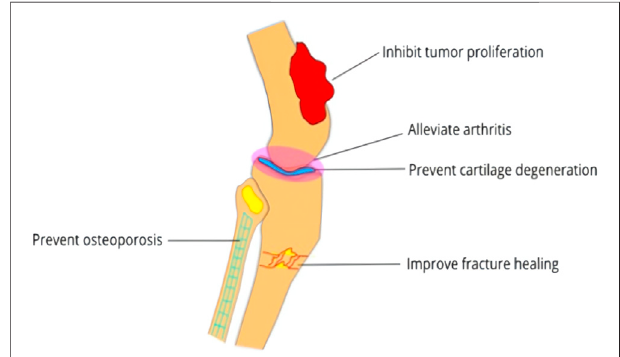
FIGURE 1 | The potential therapeutic effects of cannabinoids in bone